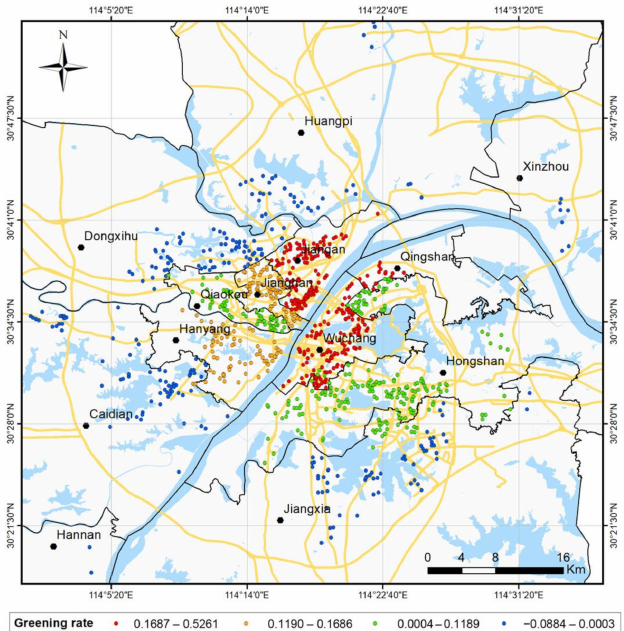
Figure 7. Greening rate coefficients map of the study